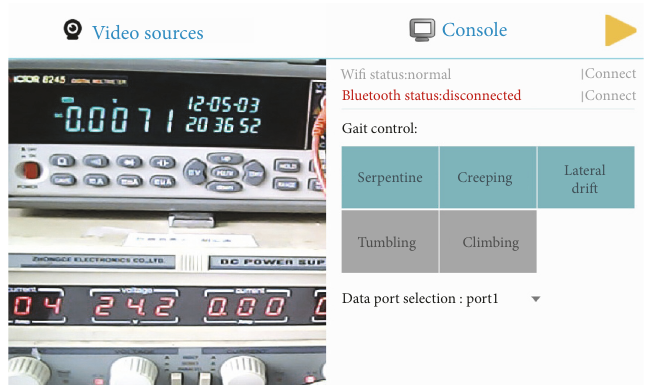
Figure 17: Video/gaits display interface.